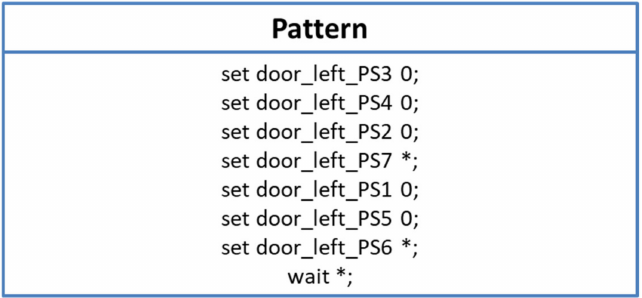
Figure 12. Query for a stimuli II.